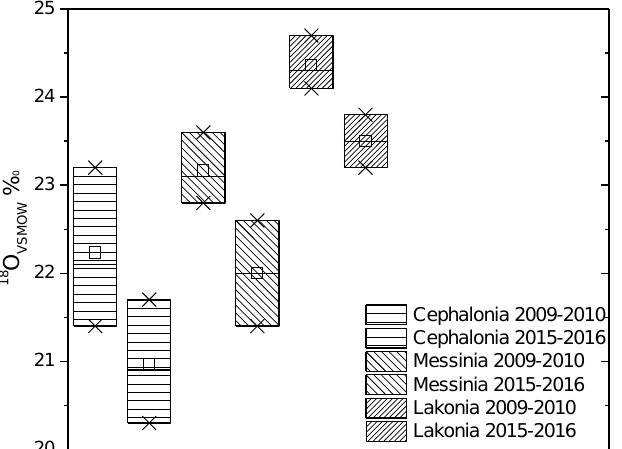
Figure 4. Comparison of δ 18 O VSMOW values of olive oils from Cephalonia, Messinia, and Lakonia between years 2009–2010 and 2015–2016.